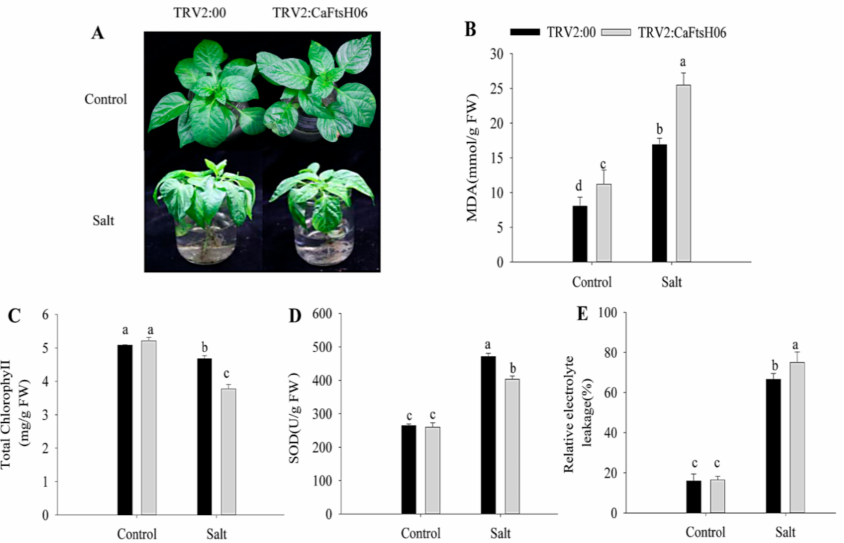
Figure 7. Salt stress tolerance analysis in silenced pepper. ( A ) Phenotypes of pTRV2:00 and pTRV2: CaFtsH06 -silenced plants after salt stress. ( B ) The MDA content of plants after salt stress. ( C ) Total chlorophyll content of plants after salt stress. ( D ) The SOD content of plants after salt stress. ( E ) The relative electrolyte leakage of plants after salt stress. Different letters denote statistical significance ( p < 0.05). For the osmotic tolerance analysis of silent and control plants, the roots of the plant samples were cleaned first and then completely immersed in a 300 mM mannitol